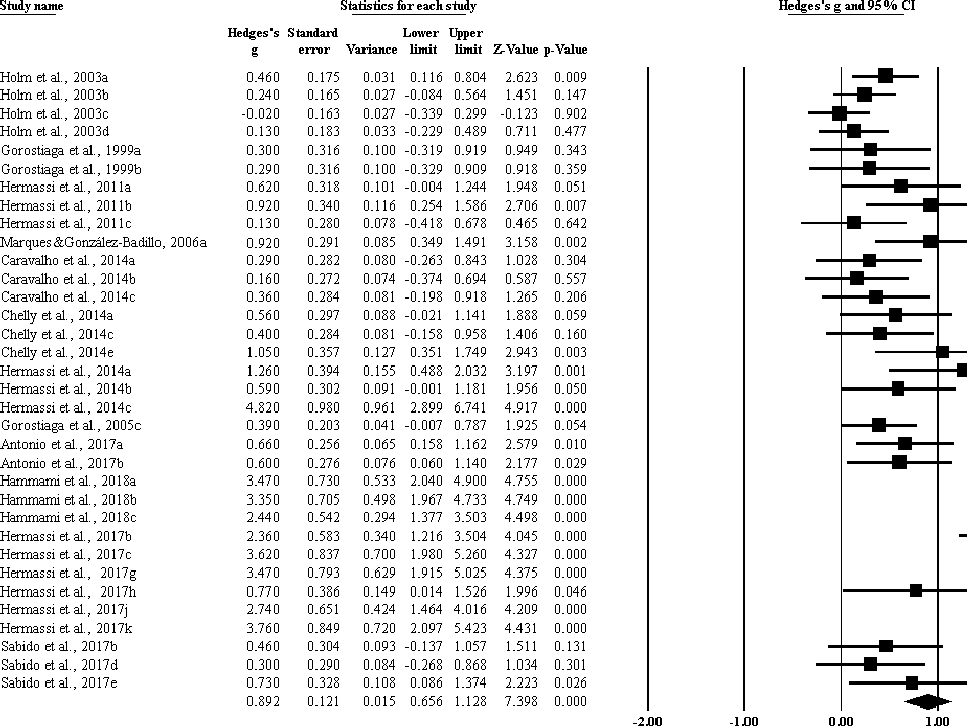
Figure 5. The impact of resistance training on maximal strength among handball players.